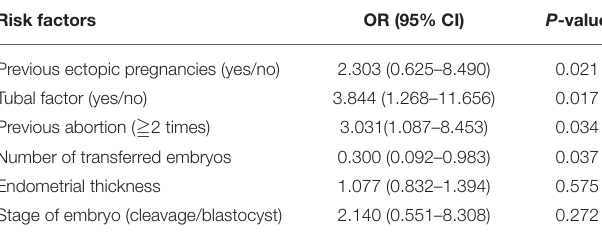
TABLE 3 | Risk factors associated with